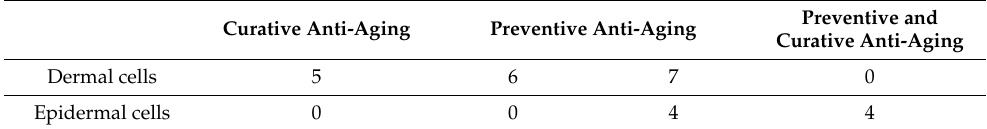
Table 3. Genetic response in presence with clarified Tisochrysis and concentrated water